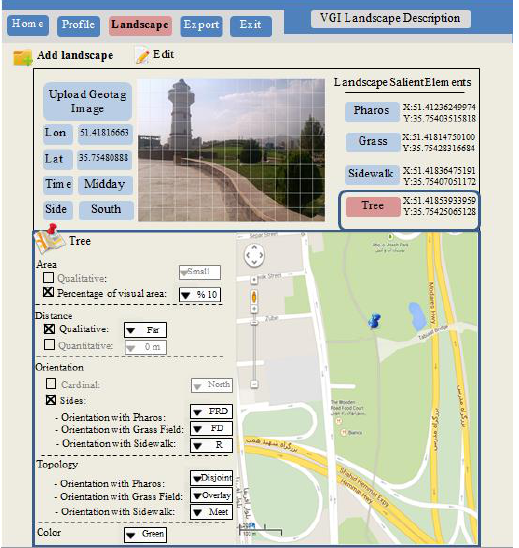
Figure 2. The web-based platform designed to collect the landscape